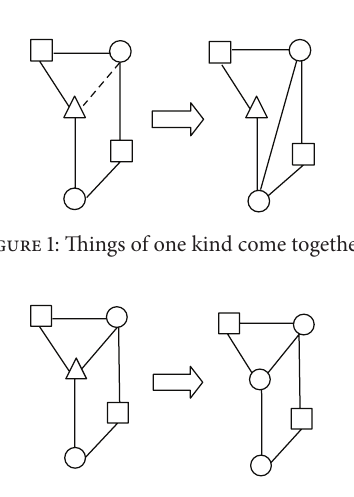
Figure 2: One takes the behavior of one’s company. Figure 3: The Y-ray represents the number of win in 100 experi- ments. The X-ray represents the proportion of two strategies. There is no noise in the